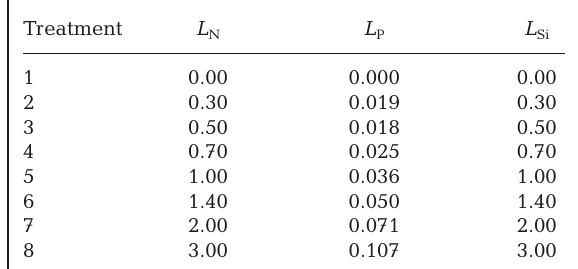
Table 1. Loading rates (µmol l −1 d −1 ) for ammonium ( L N ,